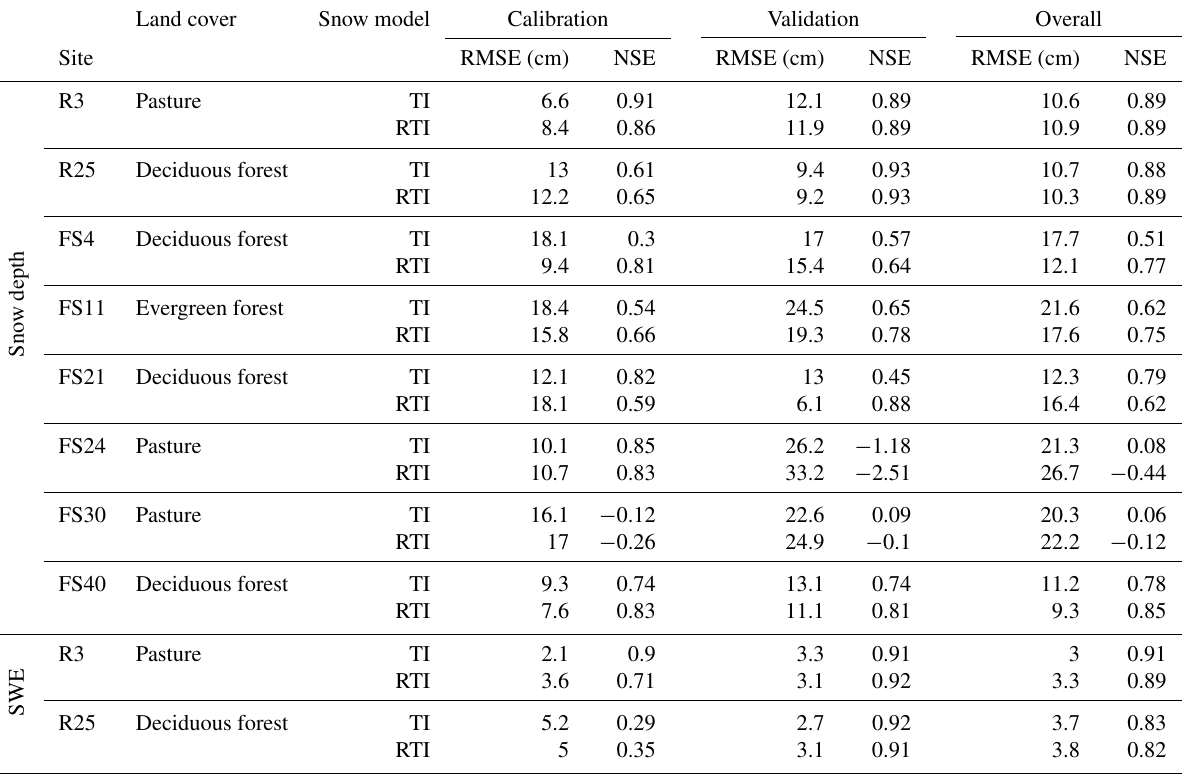
Table 4. Statistics for TI and RTI snow depth values at all eight test sites, and statistics for TI and RTI SWE values at the R3 and R25 snow test sites. Values are shown for calibration period (WY 2006–2007), validation period (WY 2008–2010), and overall (WY 2006–2010). RMSE values closer to zero and NSE values closer to one indicate better